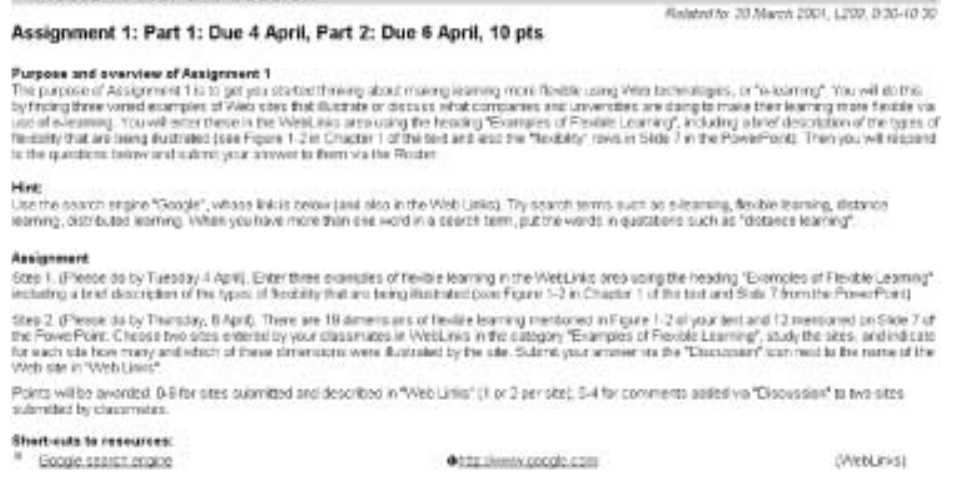
Figure 2. Building on contributions: submissions made by participants (or re-used from previous participants) can be built upon in subsequent